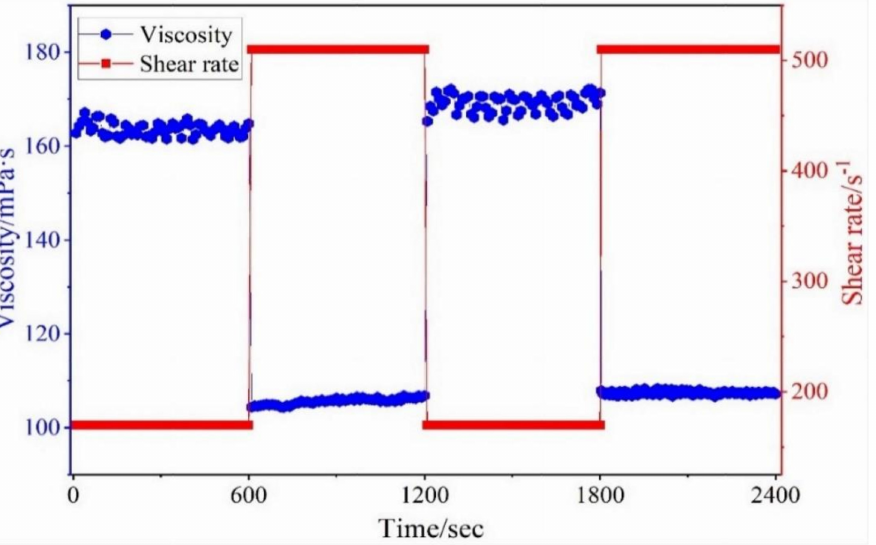
Figure 13. Shear resistance test at 25 ◦ C [103].